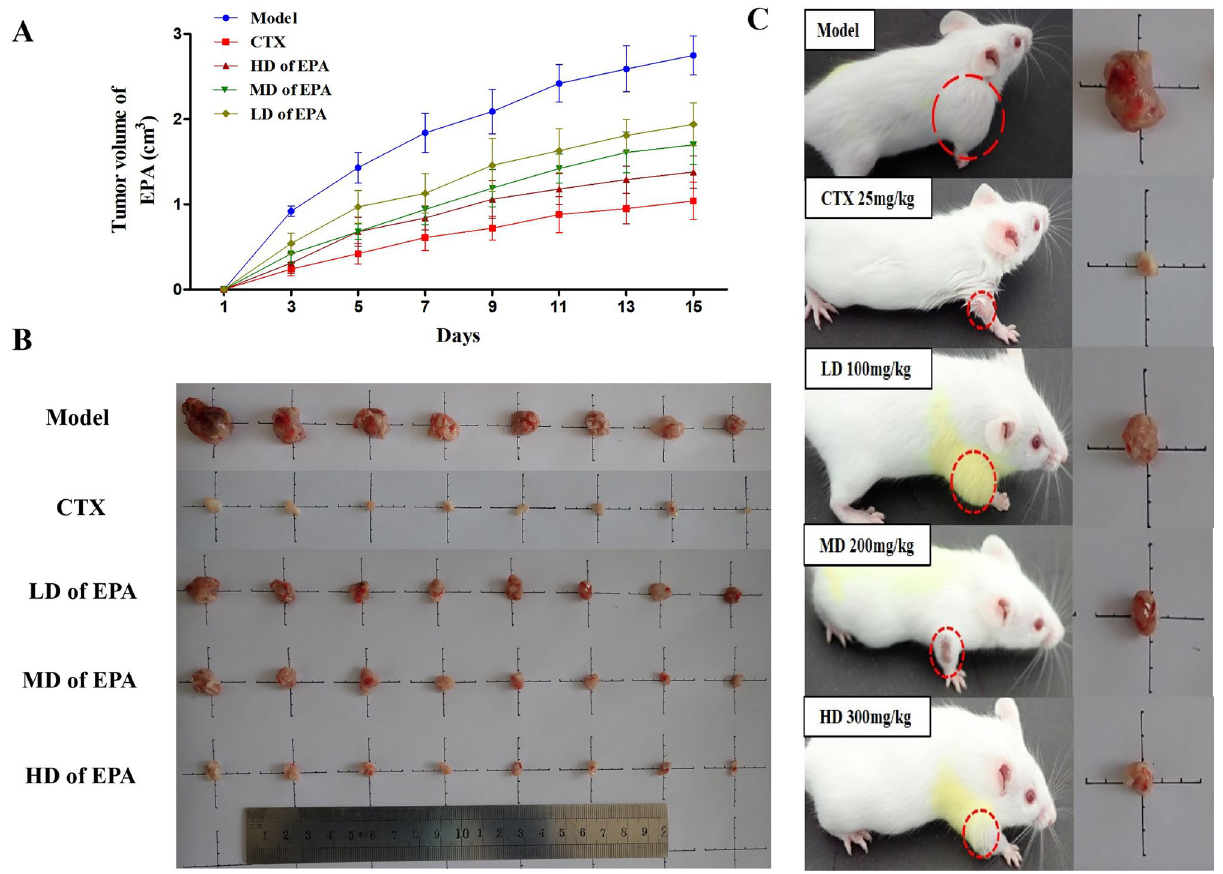
Figure 2. The effects of EPA on tumor H22 tumor-bearing mice.